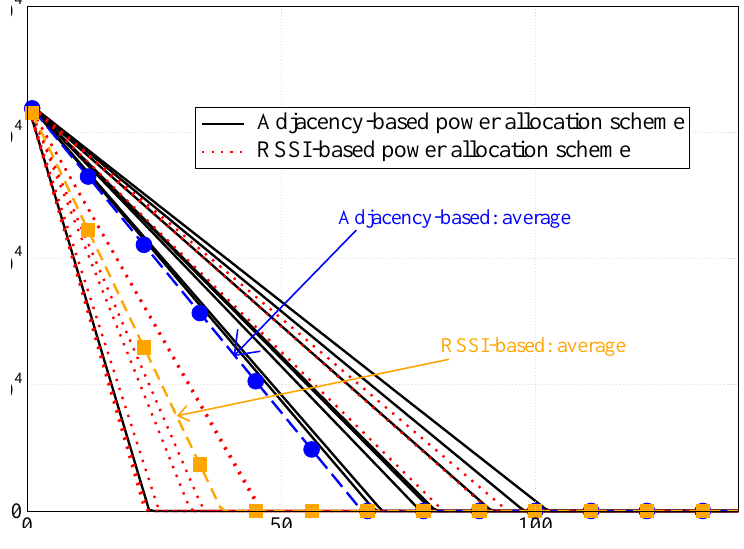
Figure 17. (i) Per-node (solid and dotted lines) and (ii) average network (dashed with sym- bols) residual energies as functions of time. Both RSSI-based (dotted lines and dashed with squares) and adjacency matrix-based (solid lines and dashed with circles) transmit power allocation schemes are considered. The target PER is P = 5 · 10 − 2 er